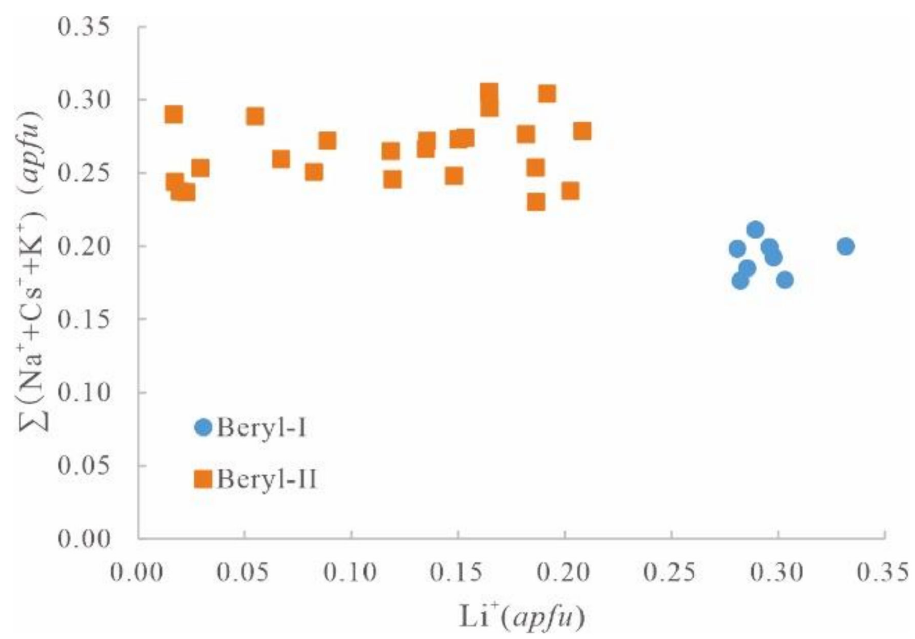
Figure 6. Li(apfu) vs. Na + Cs + K(apfu) of the beryls from the Xianglin